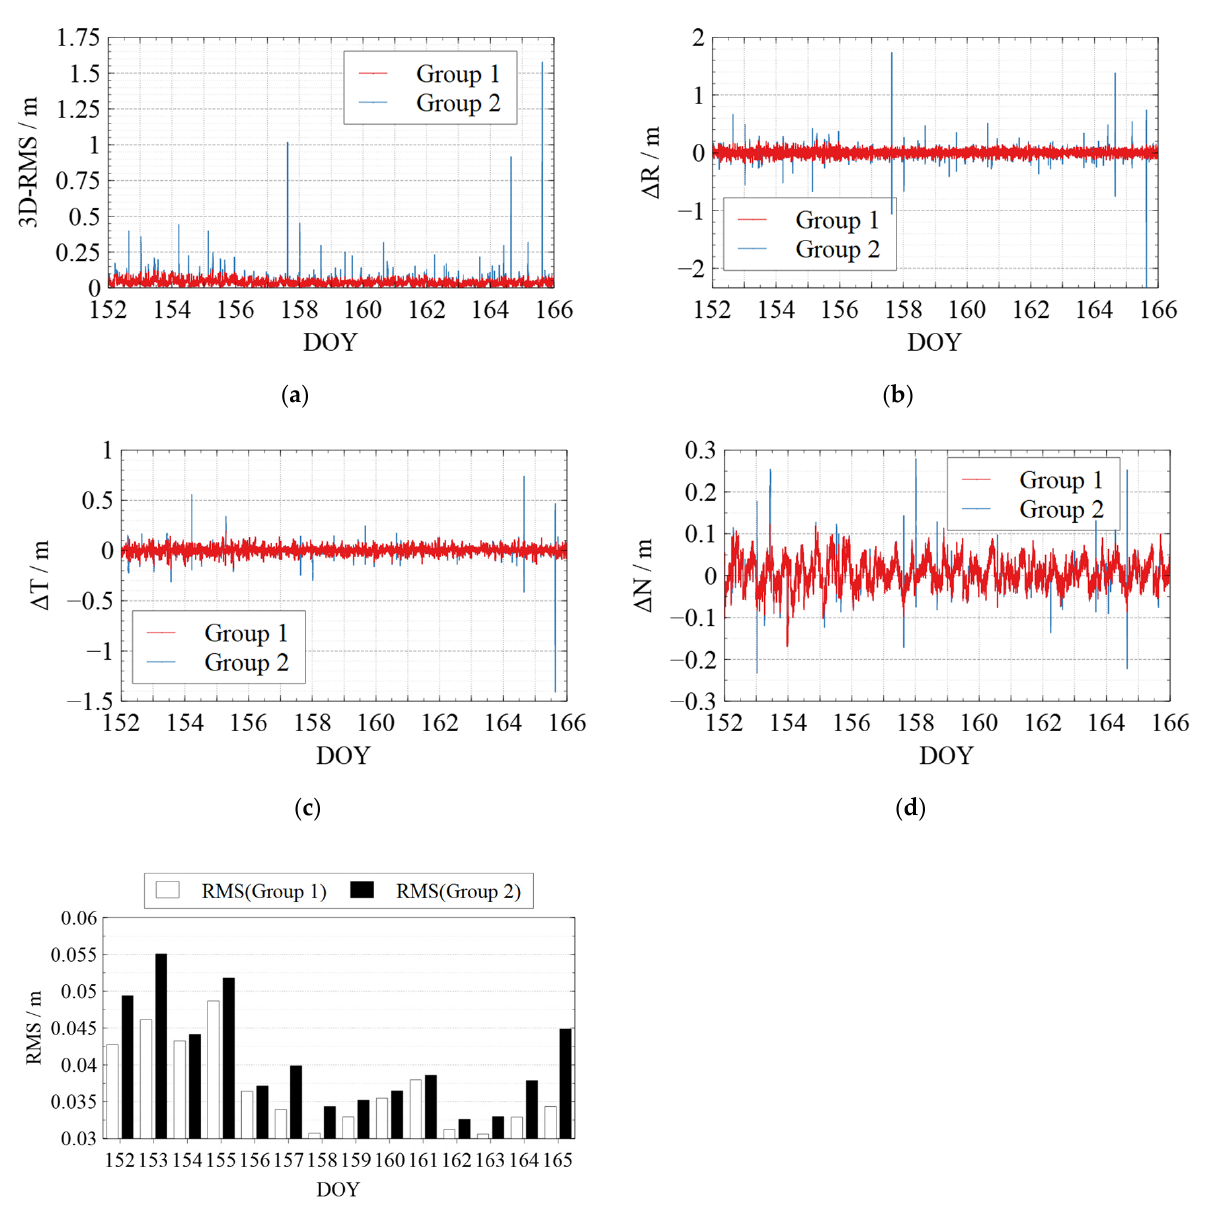
Figure 10. Comparison between the kinematic orbits of GRACE-D and the precise orbits provided by the GFZ. ( a ) 3D-RMS of the comparison results; ( b ) Difference in Radial direction; ( c ) Difference in Tangent direction; ( d ) Difference in Normal direction; ( e ) Average 3D-RMS statistics of the comparison results. The red line shows the results of Group 1, while the blue line shows the results of Group 2 in ( a – d ). The white blocks and black blocks in ( e ) represent the RMS of Group 1 and Group 2 on each day, respectively.